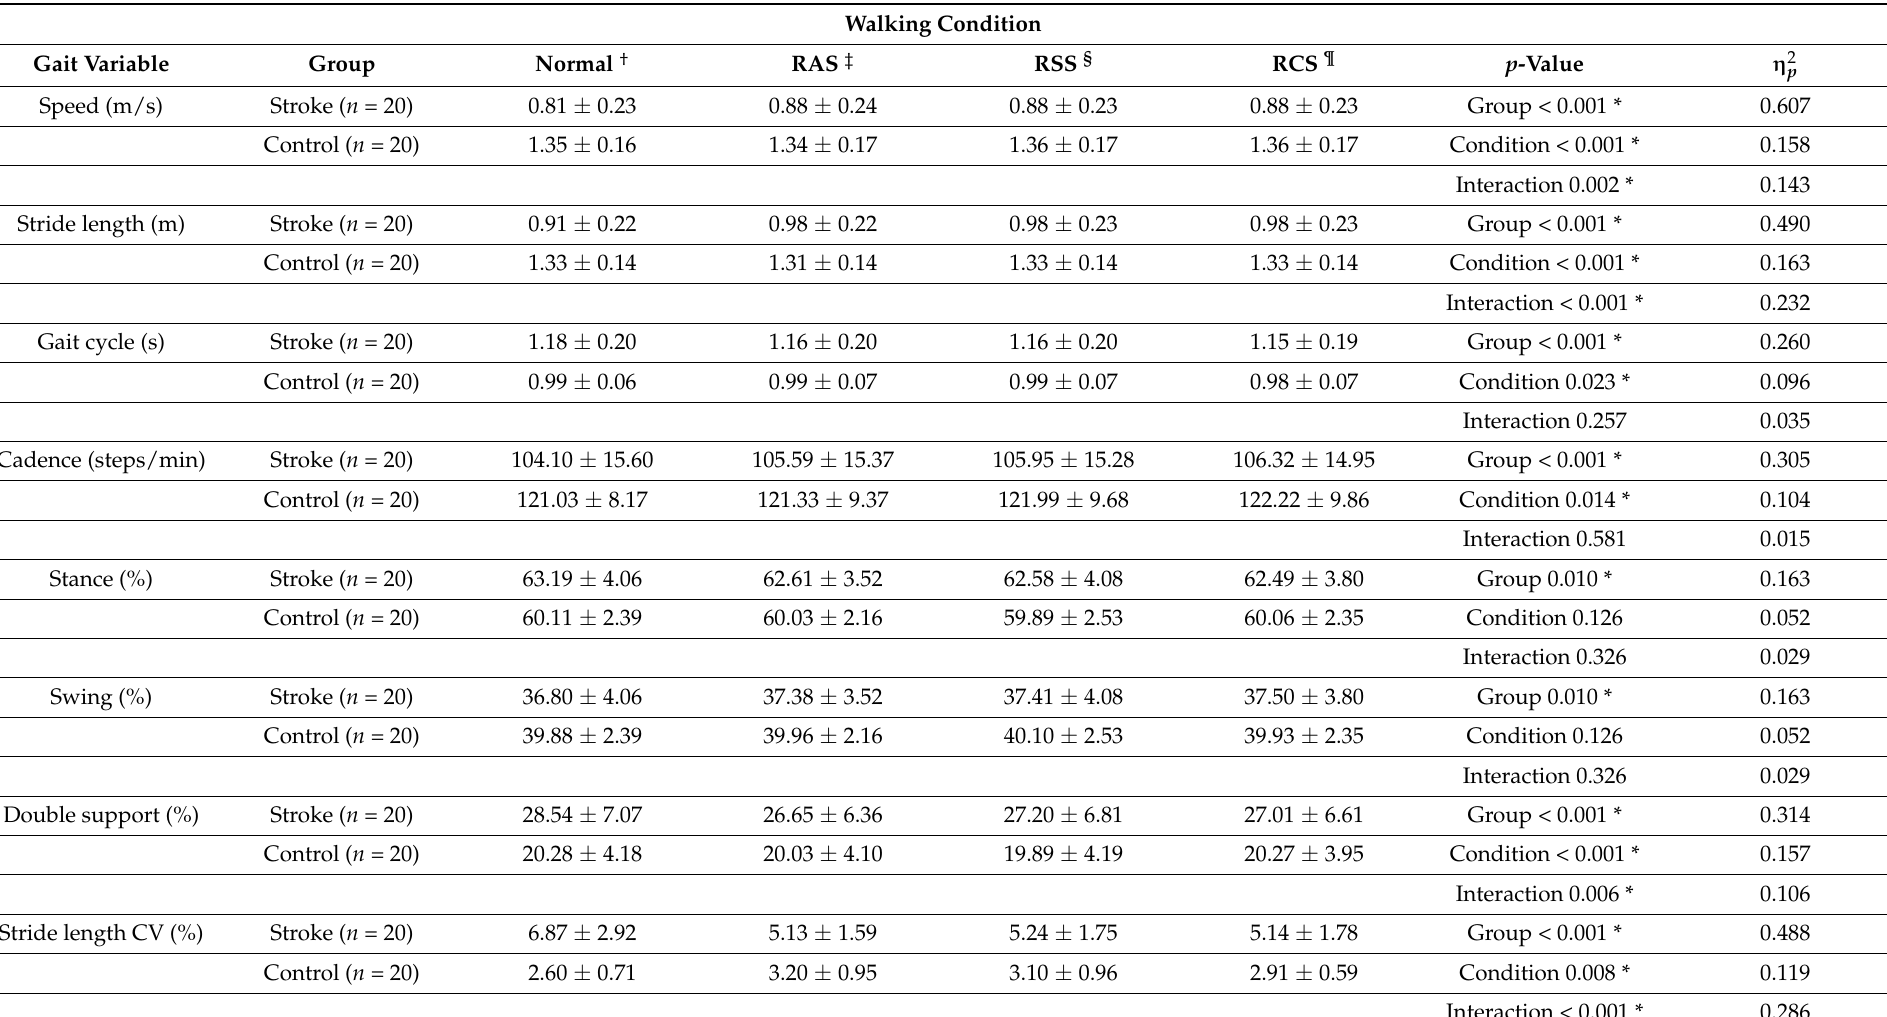
Table 2. Results of gait parameters on walking condition in stroke and control